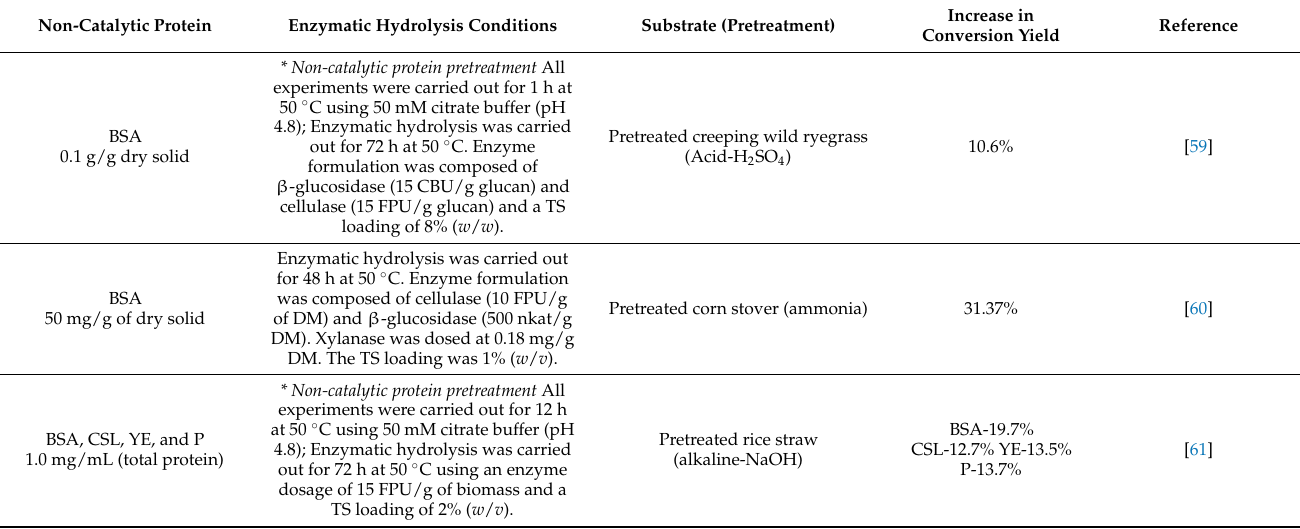
Table 2. Non-catalytic proteins as additives to enhance the enzymatic hydrolysis of lignocellulosic